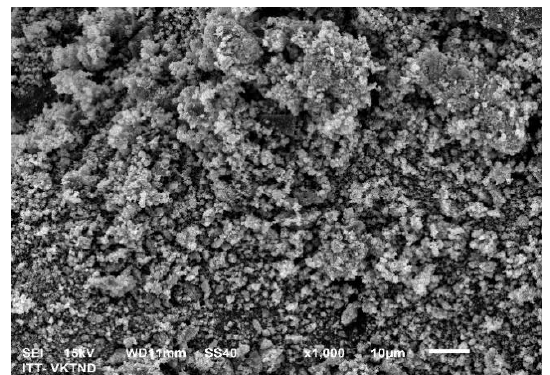
Figure 2. SEM image of Fe-Cu material.